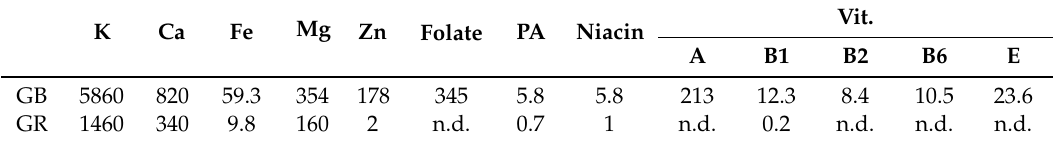
Table 1. Composition of ginsenoside in ginseng berry extract (GB) and ginseng root extract (GR). K Ca Fe Mg Zn Folate